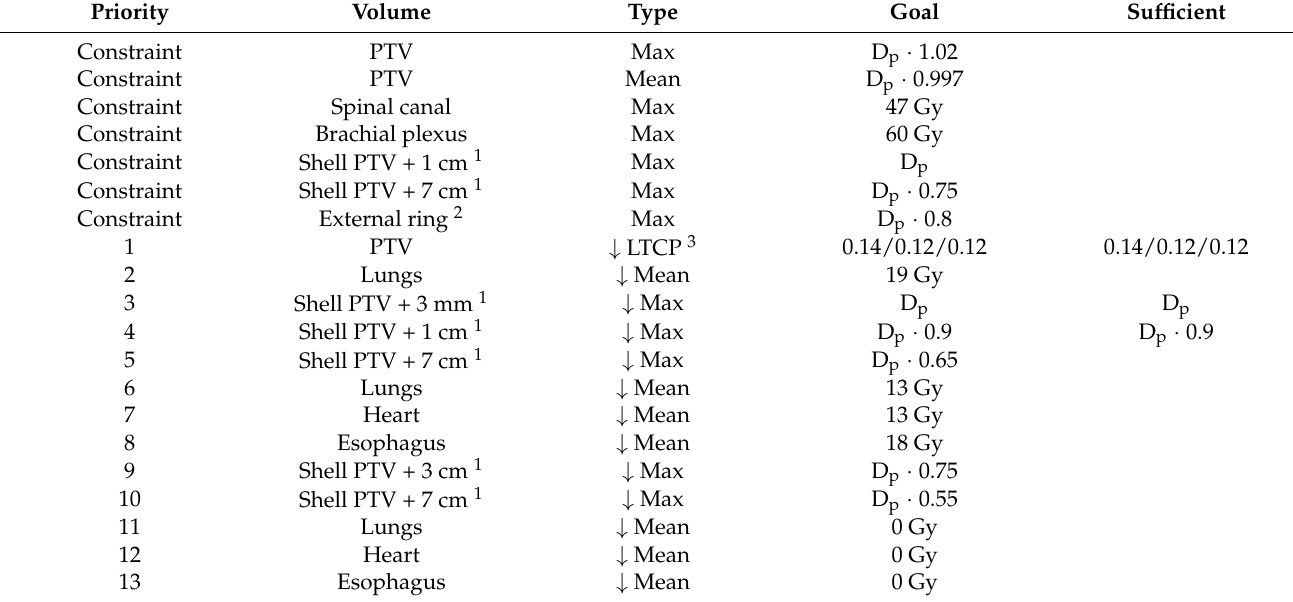
Table 2. Applied Erasmus-iCycle wish-list. D p = prescribed dose, 60/66/70 Gy; different logarithmic tumor control probability (LTCP) settings were used depending on D p . Note that the goal value for constraints was set slightly stricter than the actual clinical limit to account for finite sampling resolution.